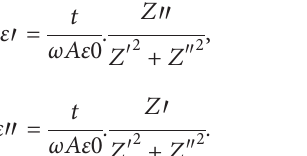
2 O 5 film gate di-